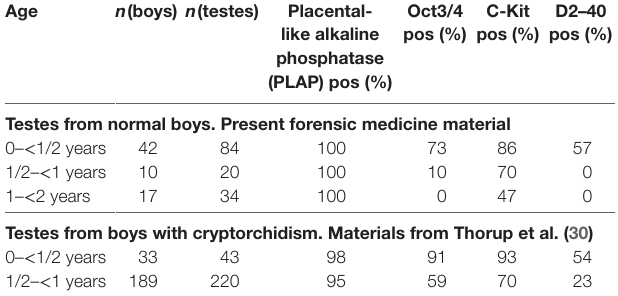
TaBle 2 | Previously reported immunohistochemical staining of primordial germ cells (PGC’s) and germ cells in fetuses and neonates. Pgc